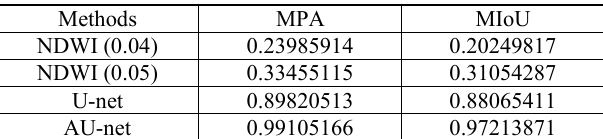
Table 2 Evaluation accuracy of the network model